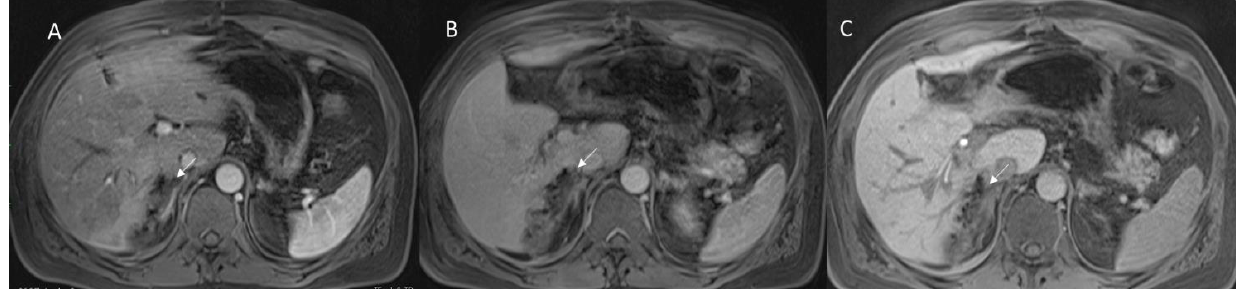
Figure 2. Hepatic abscess in resected cholangiocarcinoma on VI hepatic segment, evaluated with MRI. Arrow shows air artifacts within the collection and hyperenhancement of hepatic parenchymal in arterial phase ( A ) of contrast study that disappears in portal ( B ) and hepatobiliary ( C ) phase of contrast study.